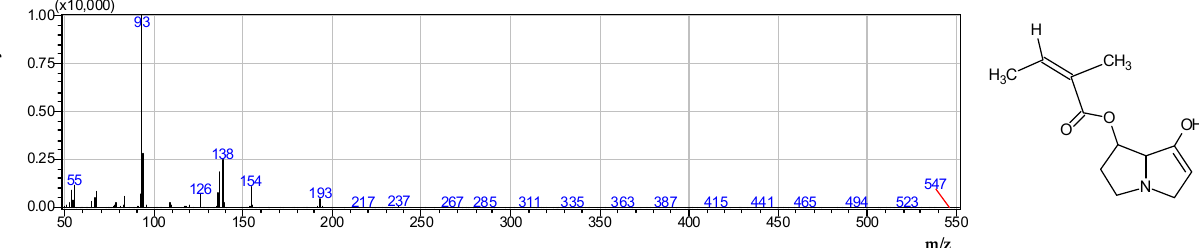
Table 4. The results of determining anti-inflammatory activity of Symphytum officinale extract samples.